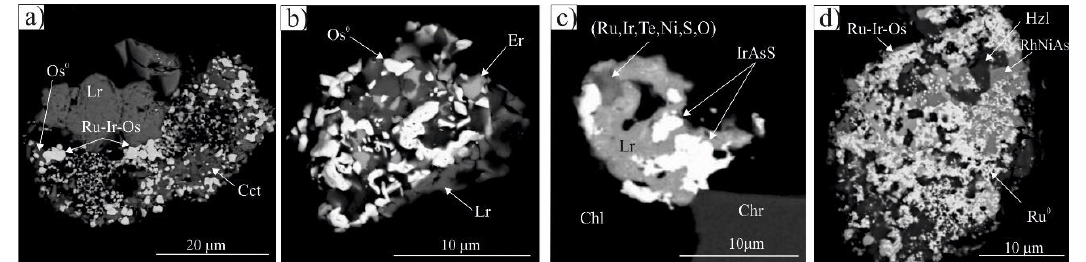
Figure 10. BSE images of secondary PGMs, showing the textural, morphological relations and assemblages of the PGM from the Ulan-Sar’dag chromitites: ( a ) intergrowth of laurite III (an. 26) and PGE bearing chalcocite Cu 2 S, with micro inclusions of Os-Ir-Ru alloys- II (an. 18); ( b ) polyphase aggregate of agglomeration PGM particles, consisting of Os-rich laurite III (an.28), native Os 0 (an. 20), and Os-poor laurite III (an. 27); ( c ) composite grain of irarsite (an. 34), laurite III (an. 29), and unnamed phases (Ru, Ir, Te, Ni, S, O) within the interstitial chlorite of chromitites; ( d ) polyphase aggregate, consisting of Os-Ir-Ru alloys-II (an. 21), Ru 0 (an. 22), zaccarinite RhNiAs (an. 35), and heazlewoodite.